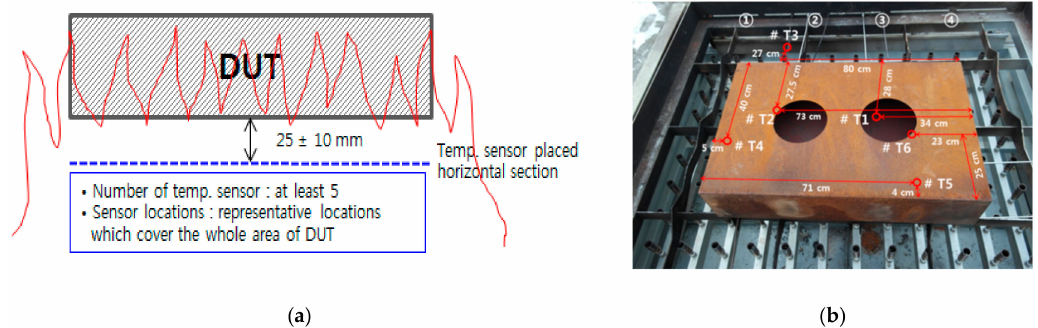
Figure 3. Vertical and planar positions of temperature measurement in prototype test apparatus: ( a ) vertical position of temperature measurement; ( b ) six positions at the horizontal plane in ( a ).